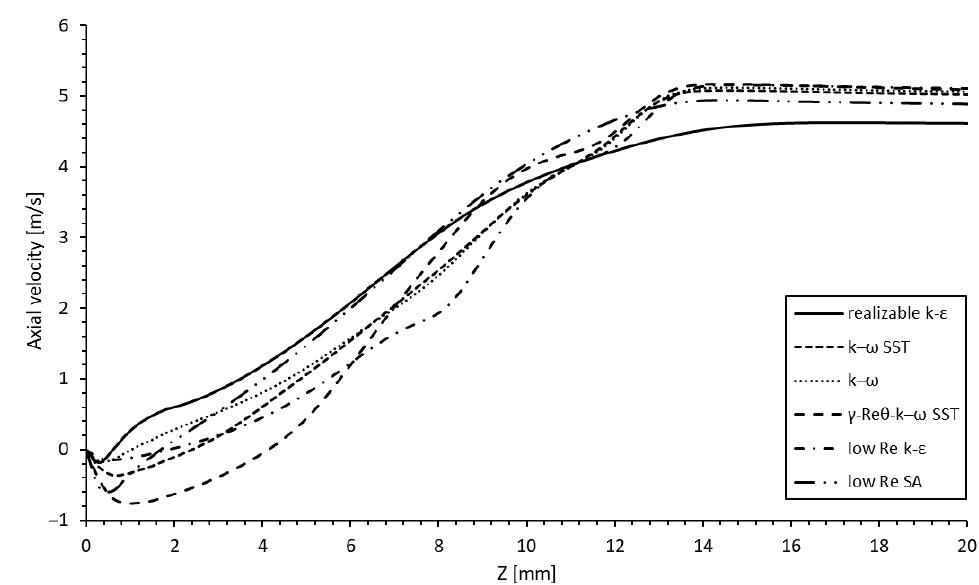
Figure 9. Simulated axial velocity magnitude at R4 for different turbulence models. The ordinate is clipped at Z = 20.